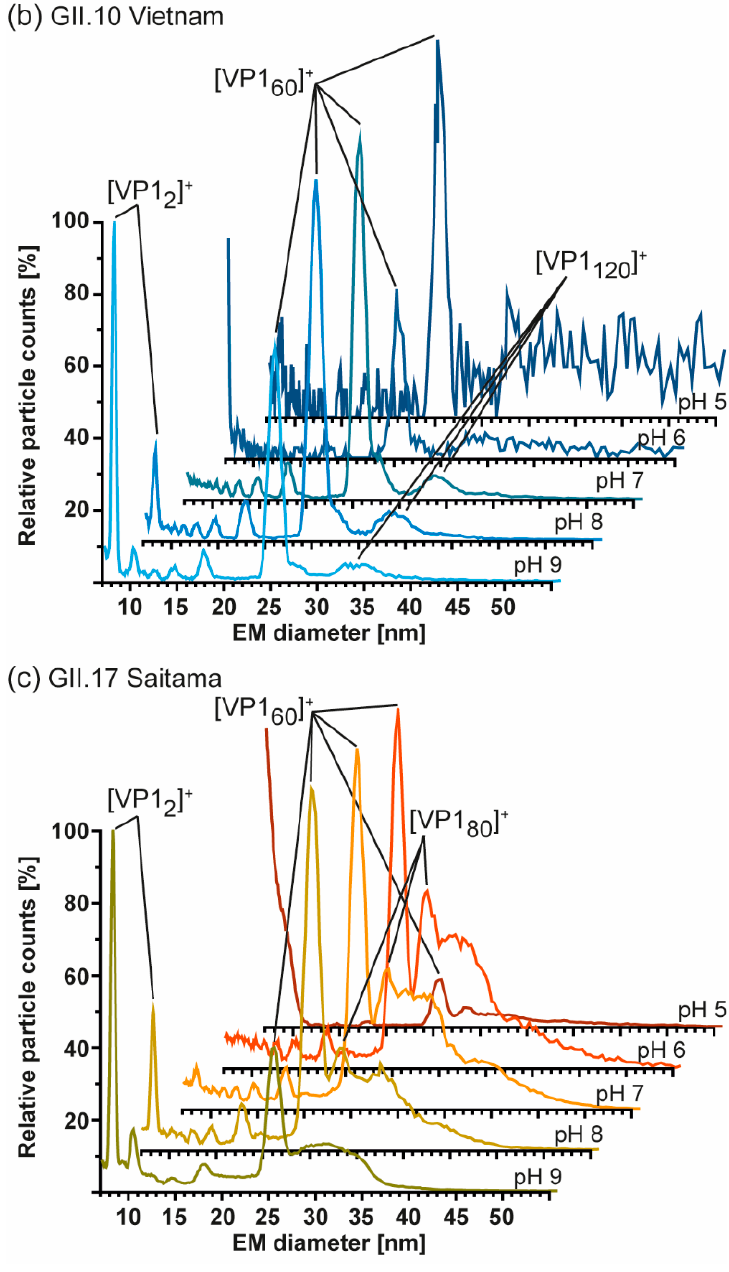
Figure 5. Measurements at different pH of hNoVLPs with GEMMA indicates high pH-resistance of T = 1 particles formed from truncated VP1. All measurements were performed at 40 mM ammonium acetate at pH 5–9 from top to bottom at approximately 2–10 µ M. ( a ) GII.4 Saga (purple) shows mainly VP1 60-mer accompanied by multiply charged VP1-60-mer. Particle patterns differ only at pH 8, where VP1 dimers are present in low counts as well as pH 9, where merely VP1 dimer is detected. ( b ) GII.10 Vietnam (blue) shows intact T = 1 particles at all tested pH values. Increased particle counts at pH 7–9 are accompanied with multiply charged VP1 60-mer. Disassembly into VP1 dimer is seen at pH 8 but is only resulting in less VP1-mer counts at pH 9. This pattern is comparable to measurements of GII.17 Saitama ( c ). Here, main VP1-mers are accompanied by heterogeneous subspecies, which are reduced under alkaline